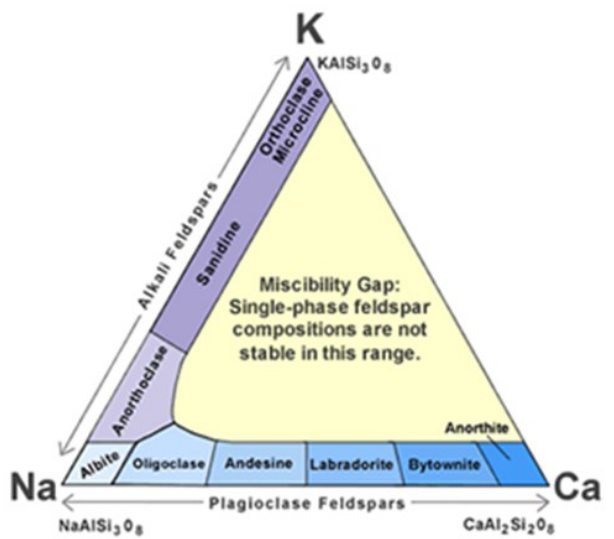
Figure 4. The ternary diagram shows how feldspar minerals are classified on the basis of their chemical composition. The sequence of minerals along the left side of the triangle represents the solid solution series of the alkali feldspars. The sequence along the base is the solid solution series of the plagioclase feldspars. A triangular graph paper can be obtained from